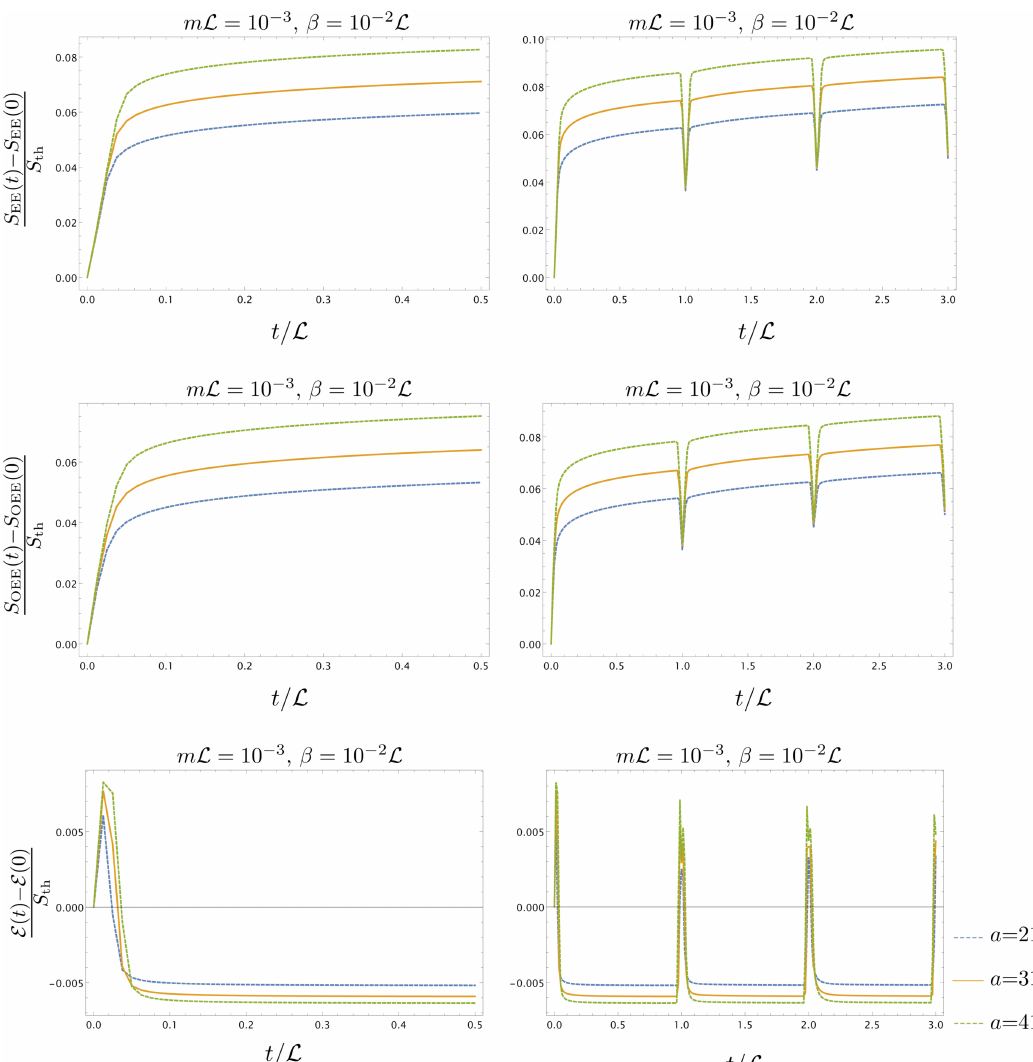
Figure 2 . Time evolution of S EE , S OEE and E in free massless scalar theory for various time regimes and various size of entangling regions, where the initial values are subtracted and the result is normalized with respect to the thermal entropy S 20+ a . The upper-left plot denotes the growth of S the size of an interval. The upper-right plot is for longer periods of time. One can see the finite size effects which induce a periodic behavior with periodicity L . We see a logarithmic growth due to the presence of a zero-mode which we study further analytically in the next section. The middle-left and right panels denote the time dependency of S S OEE are the same. The bottom-left plot denotes the short-time behavior of E . In early times we see growth and then reduction with respect to the initial value of LN. The bottom-right plot is for a long time regime, in which the finite size effect exhibit itself as periodic